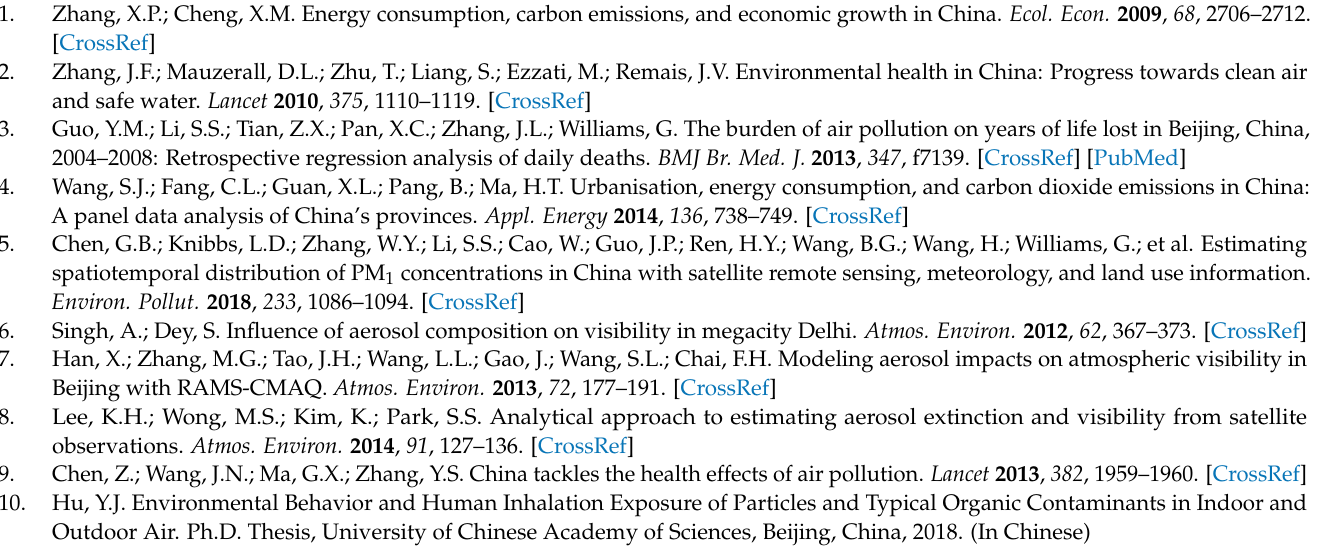
Table S5: The reference concentration limits for PTEs (GB